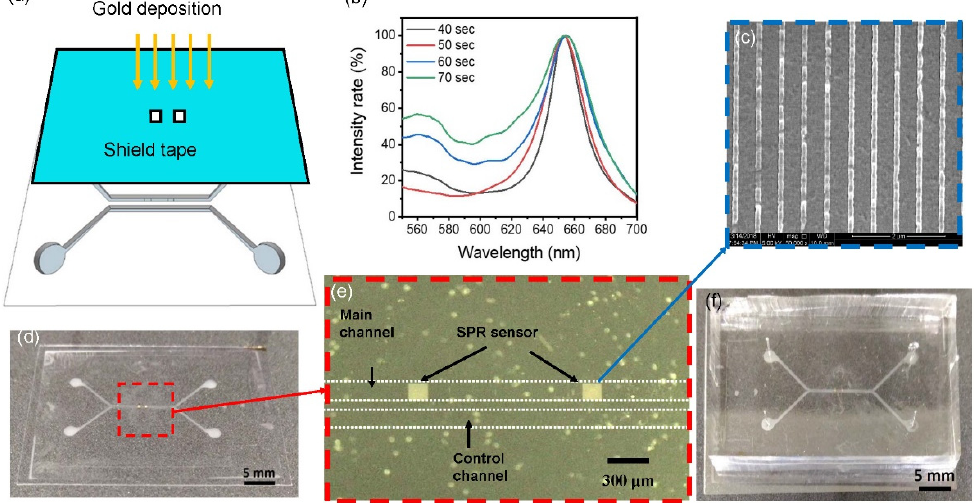
Figure 3. ( a ) Covering the opening with shadow tape and depositing gold. ( b ) The thickness of the